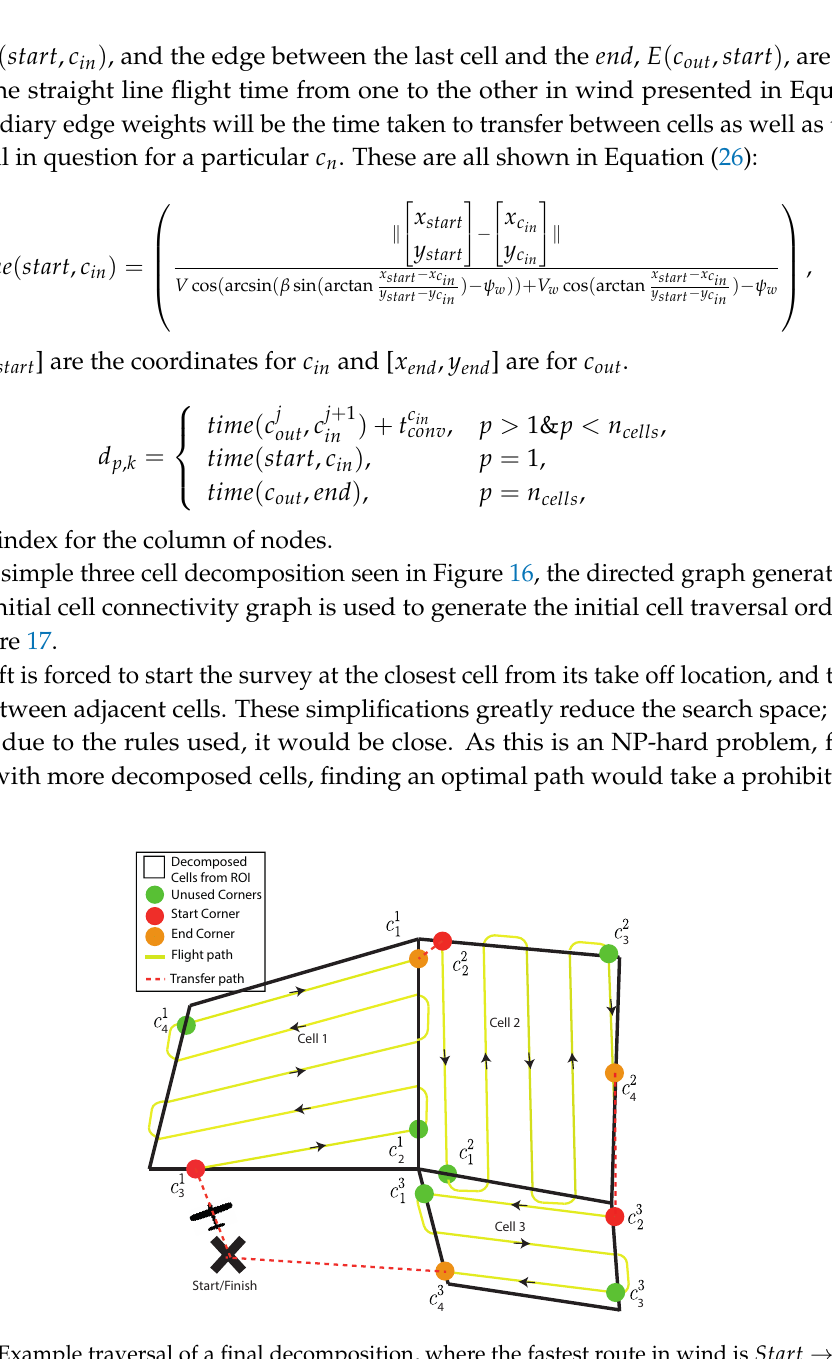
Figure 16. Example traversal of a final decomposition, where the fastest route in wind is Start → c 1 → c 2 → c 2 → c 3 → c 3 → end c 1 2 2 1 4 4